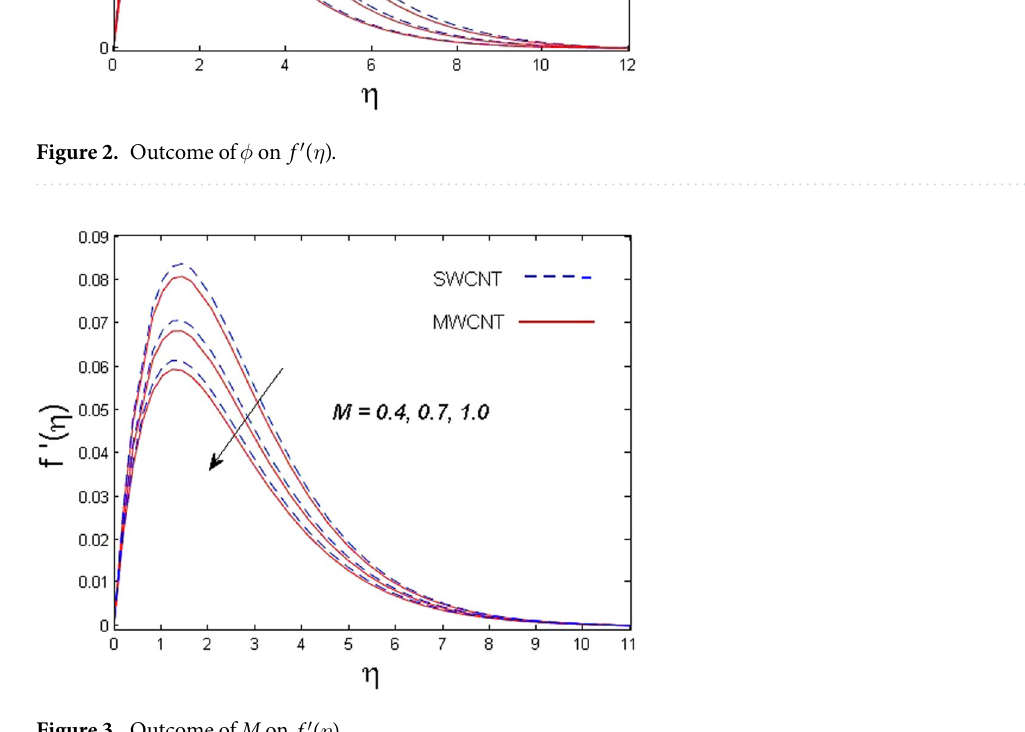
Figure 3. Outcome of M on η ′ f ( )